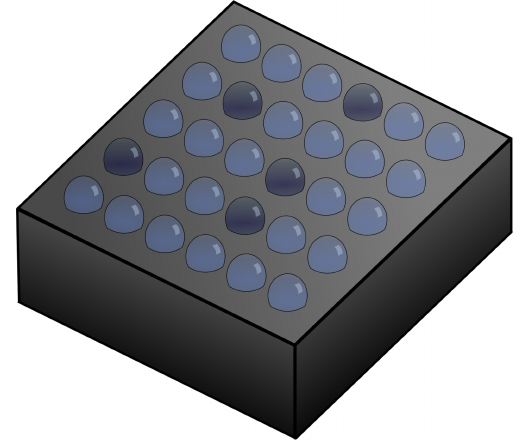
Figure 1. Schematic of a typical cold plate array, with droplets ar- ranged in a grid on a heat sink. The heat sink is typically cooled by liquid nitrogen or a Peltier device. The diagram shows some droplets frozen